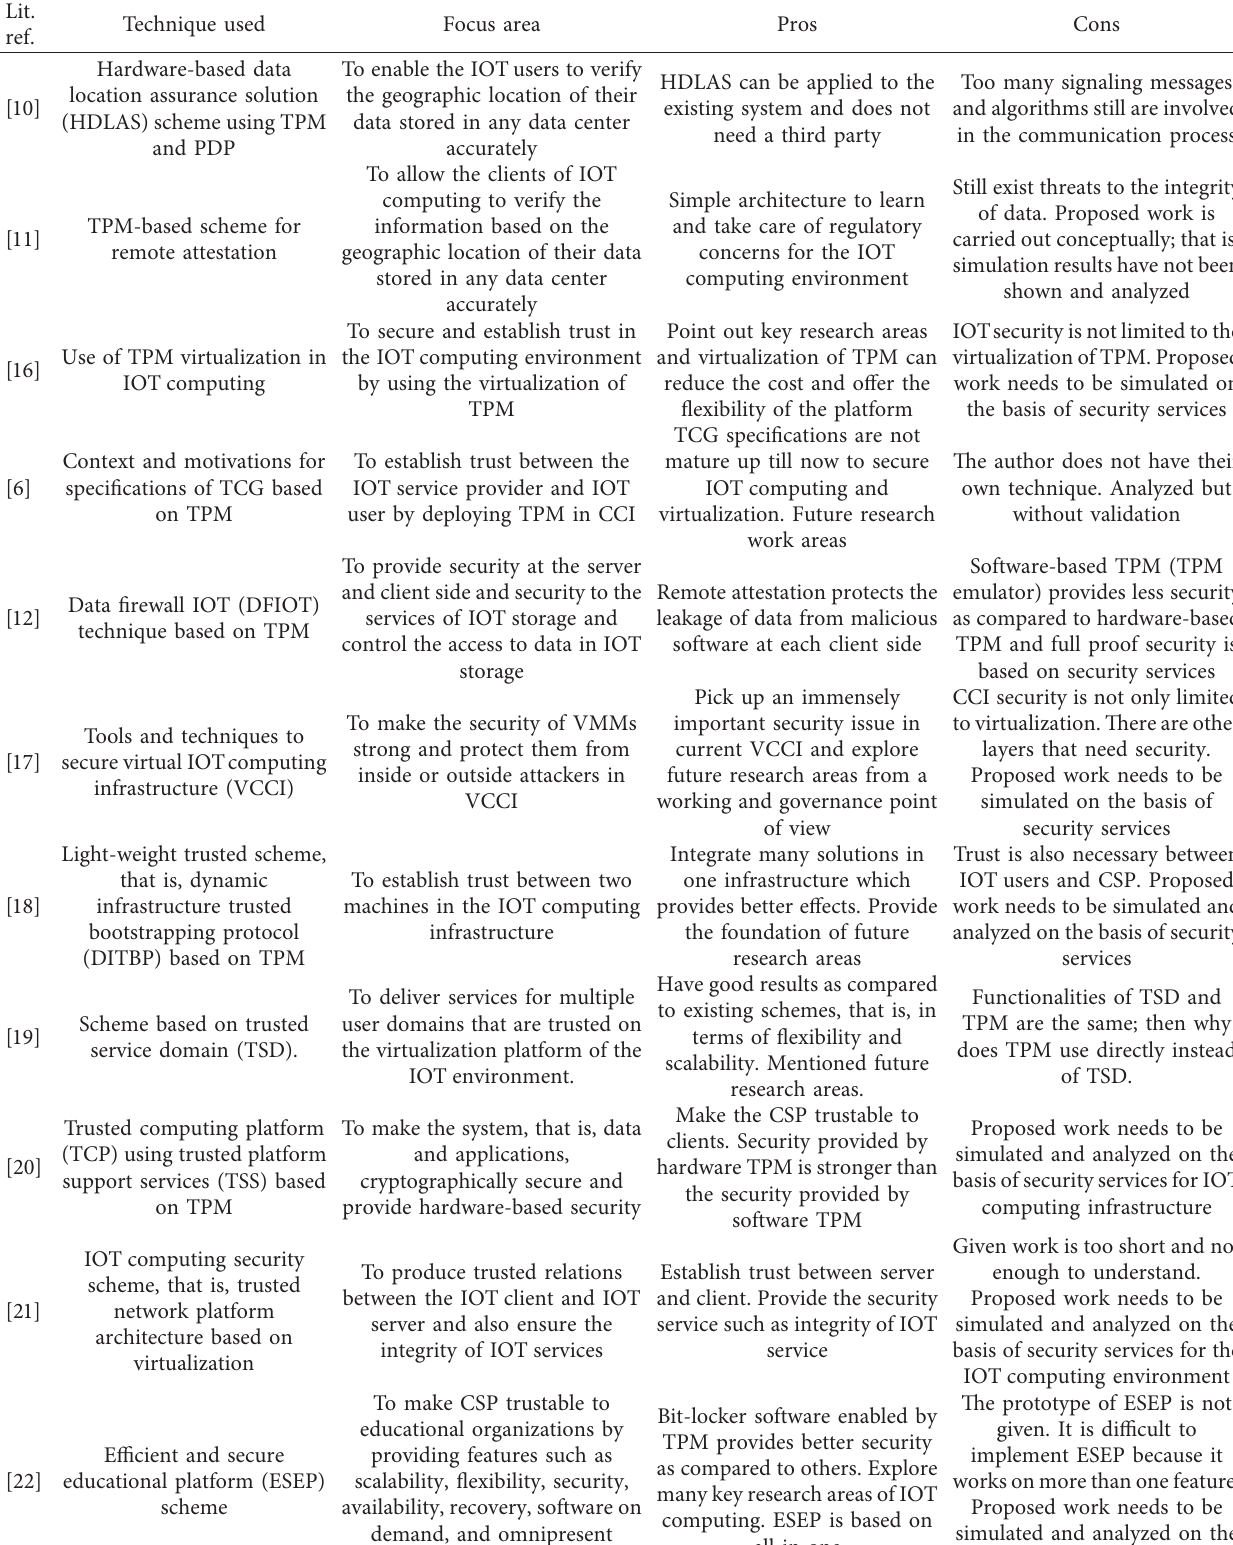
Table 1: Critical evaluation of the schemes discussed in the